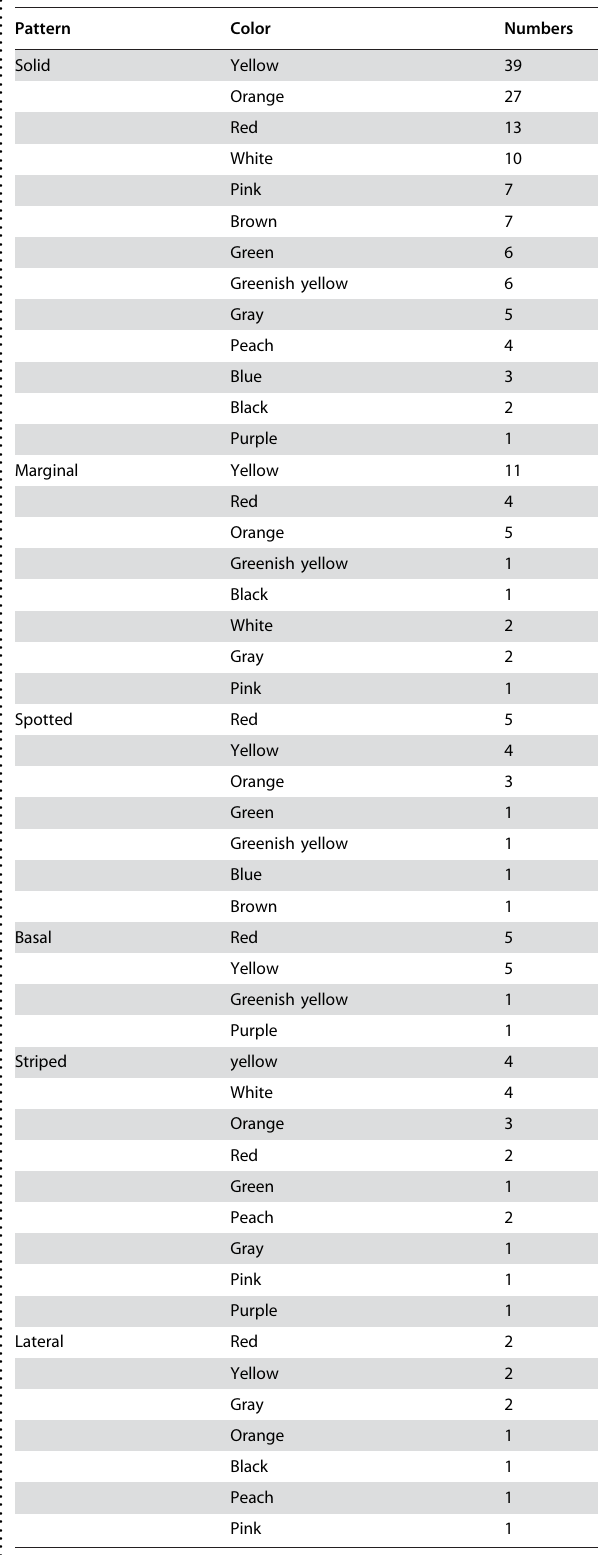
Numbers in the right-hand column refer to the number of morphs exhibiting the color in the indicated pattern, yielding an indication of color diversity within each pattern.